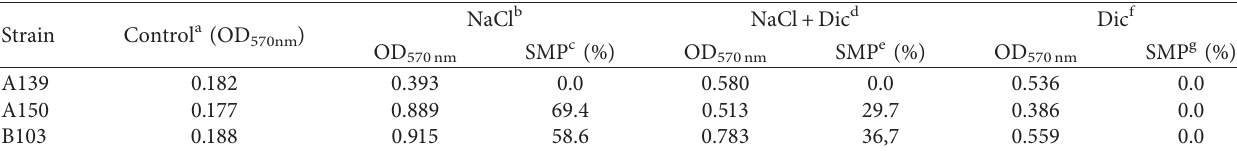
Table 2: Degree of degradation of biofilm induced by NaCl and diclofenac after treatment with sodium metaperiodate in 3 strains of S. aureus .